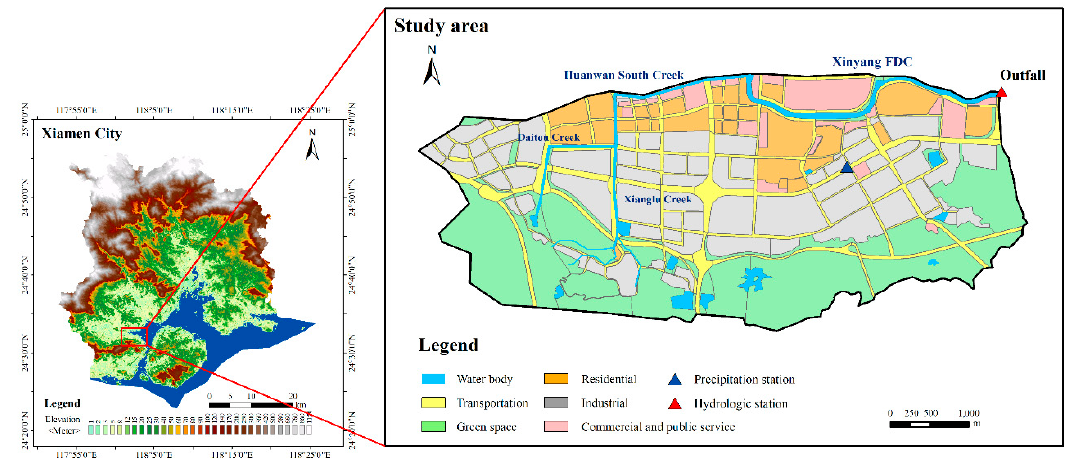
Figure 1. Location of study area and schematic representation of the Xinyang flood drainage canal (FDC) watershed.